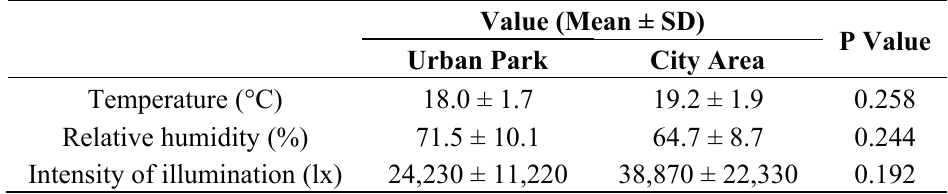
Table 1. Physical variables measured in the urban park and city